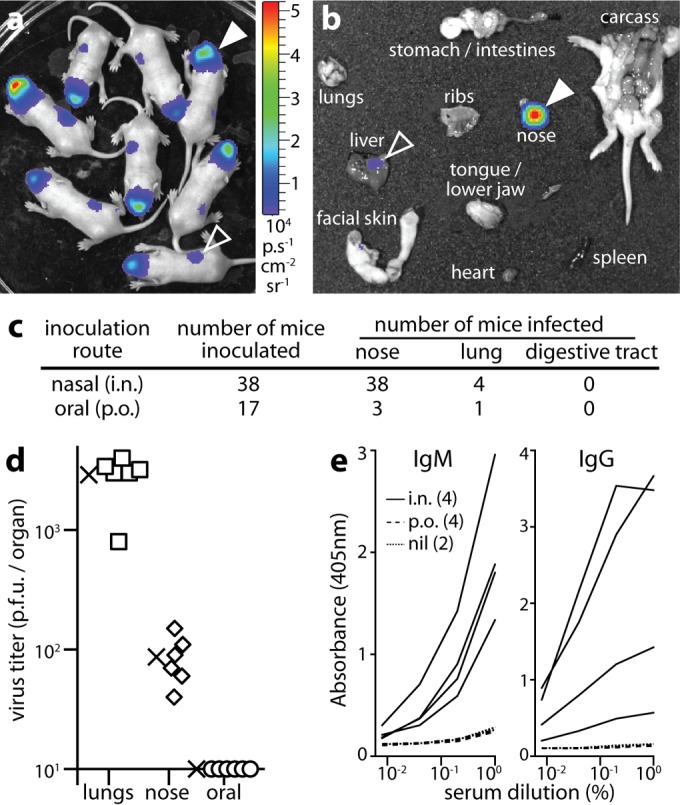
MCMV infects pups nasally. (a) BALB/c pups imaged 2 days after i.n. MCMV-LUC (3 × 104 PFU) showed nasal luciferase signals (filled arrowhead). Liver signals (open arrowhead) were nonspecific. The images shown are representative of the images for 26 mice. The heatmap color bar shows 104 photons/s/cm2/sr. (b) Dissection at day 2 confirmed nasal infection (filled arrowhead) and weak liver signals (open arrowhead). The images shown are representative of the images for 12 mice. (c) MCMV was consistently more infectious i.n. than p.o., and MCMV infected noses more commonly than it infected lungs (both P < 10−4 by Fisher's exact test). At day 4 postinoculation, no mice had oropharyngeal or gastrointestinal signals, and all mice infected p.o. were infected in the respiratory tract. Results were pooled from three independent experiments. (d) At 4 days after i.n. inoculation, noses were plaque assayed for infectious virus and compared with the lungs of mice that had luciferase-positive lungs (due to inoculum aspiration), and the oropharynges of mice given MCMV p.o. (oral). The means are indicated by × symbols. The other symbols represent the values for individual mice. The x axis shows the limit of assay sensitivity. (e) At 1 month postinoculation, mice were assayed for MCMV-specific serum IgG and IgM by ELISA. The mice were given MCMV i.n. (with no evidence of lung infection; n = 4), MCMV p.o. (with no evidence of respiratory infection; n = 4), or no virus (nil; n = 2).